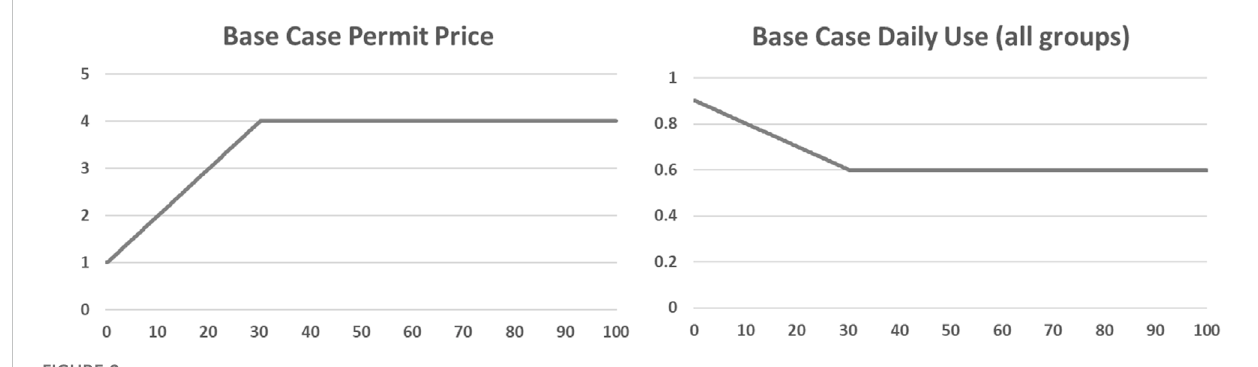
FIGURE 2 Permit price and daily car-use of car user groups under base conditions.